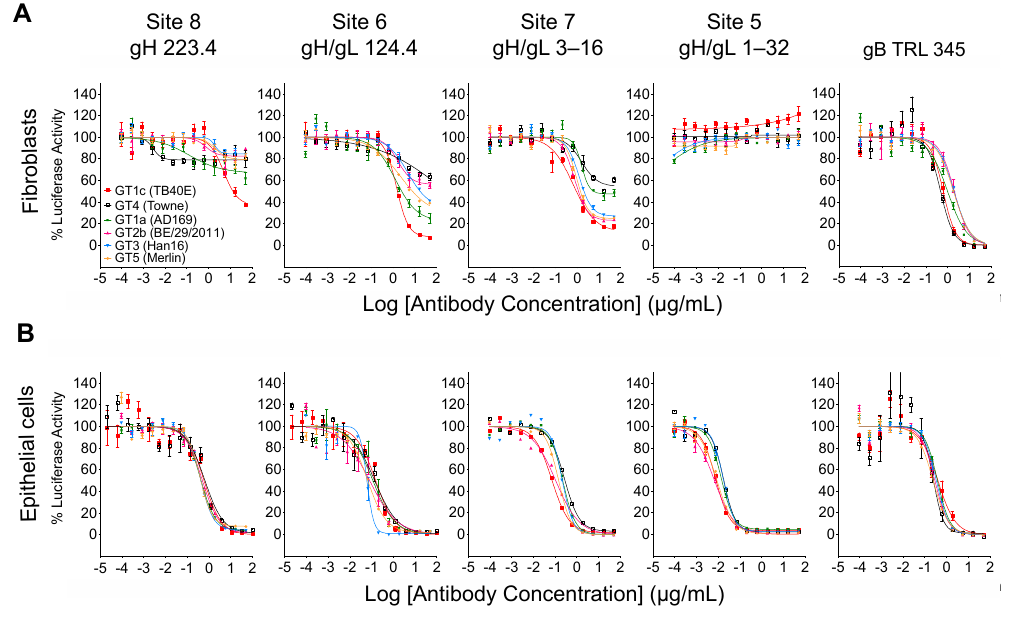
Figure 5. Other gO types influence fibroblast entry neutralization by gH/gL-specific mAbs in an epitope-specific manner. Four additional TB40/E-background chimeric viruses encoding gOs from strains AD169, Merlin, Han16, or BE/29/2011 were used in fibroblast ( A ) or epithelial cell ( B ) entry neutralizing assays as described in Figure 3.